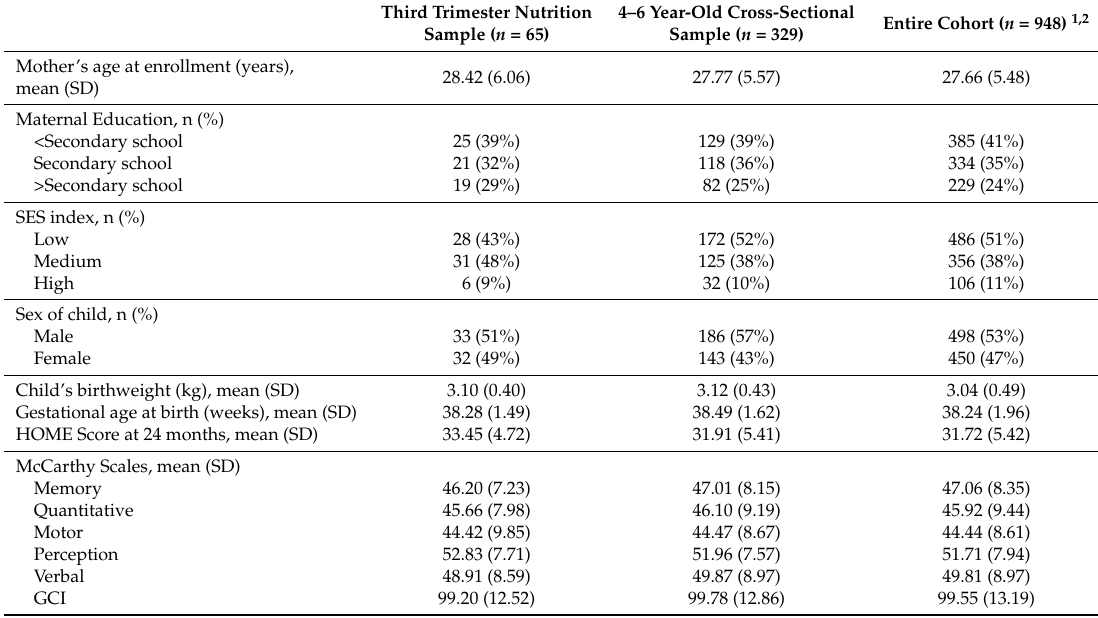
Table 1. Sociodemographic and psychometric characteristics of mothers and their